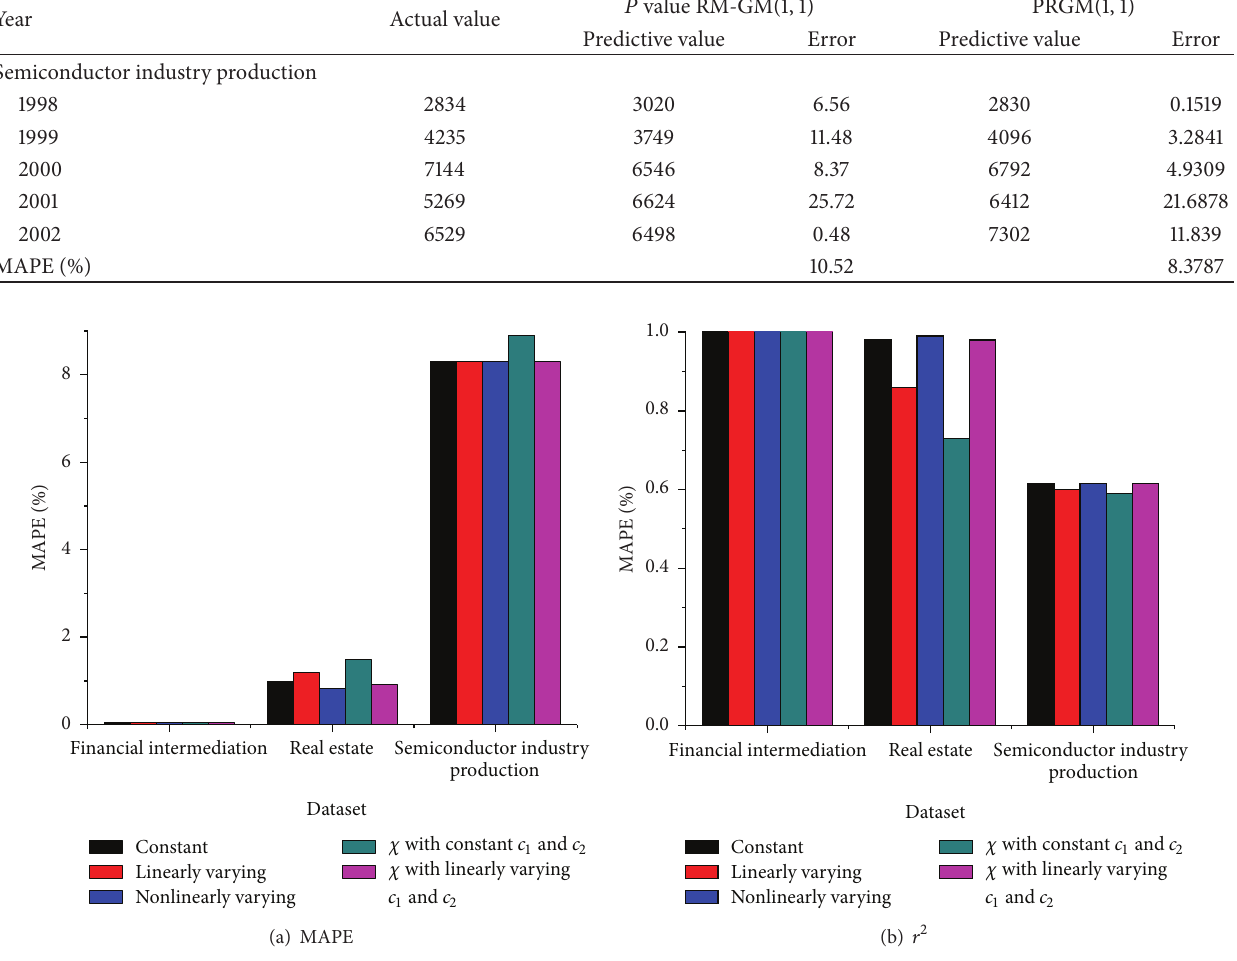
Figure 1: The influence of PSOs with various parameter settings on MAPE and 𝑟 2